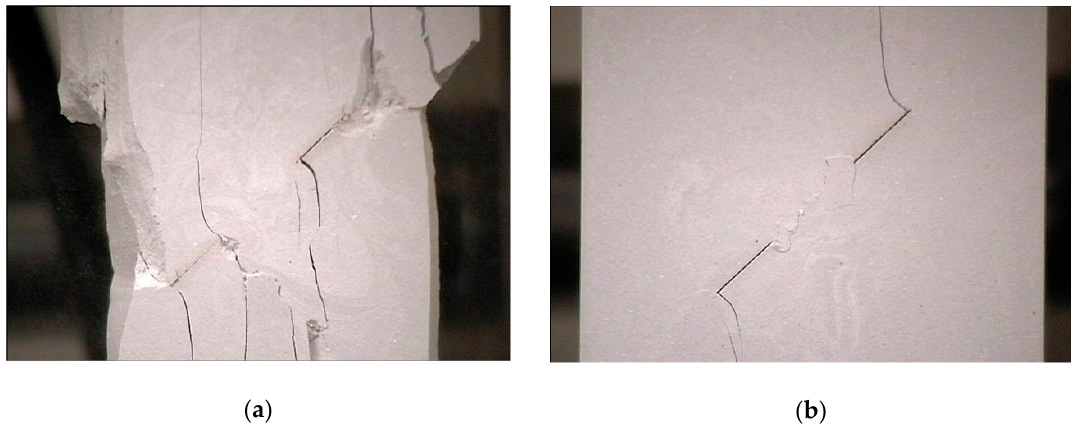
Figure 16. Difference in the coalescence type in monotonic and cyclic loading. ( a ) Monotonic loading. ( b ) Cyclic loading.